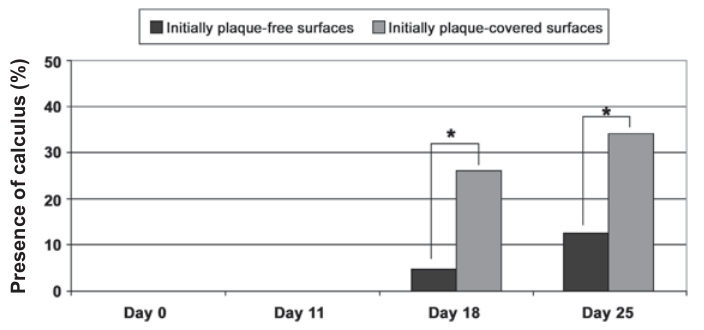
Figure 5- Frequency of sites with presence of calculus Table 1- Mean calculus scores on days 0, 11, 18 and 25 Presence/absence of Initially plaque-free surfaces (Control) Initially plaque-covered surfaces (Test) calculus